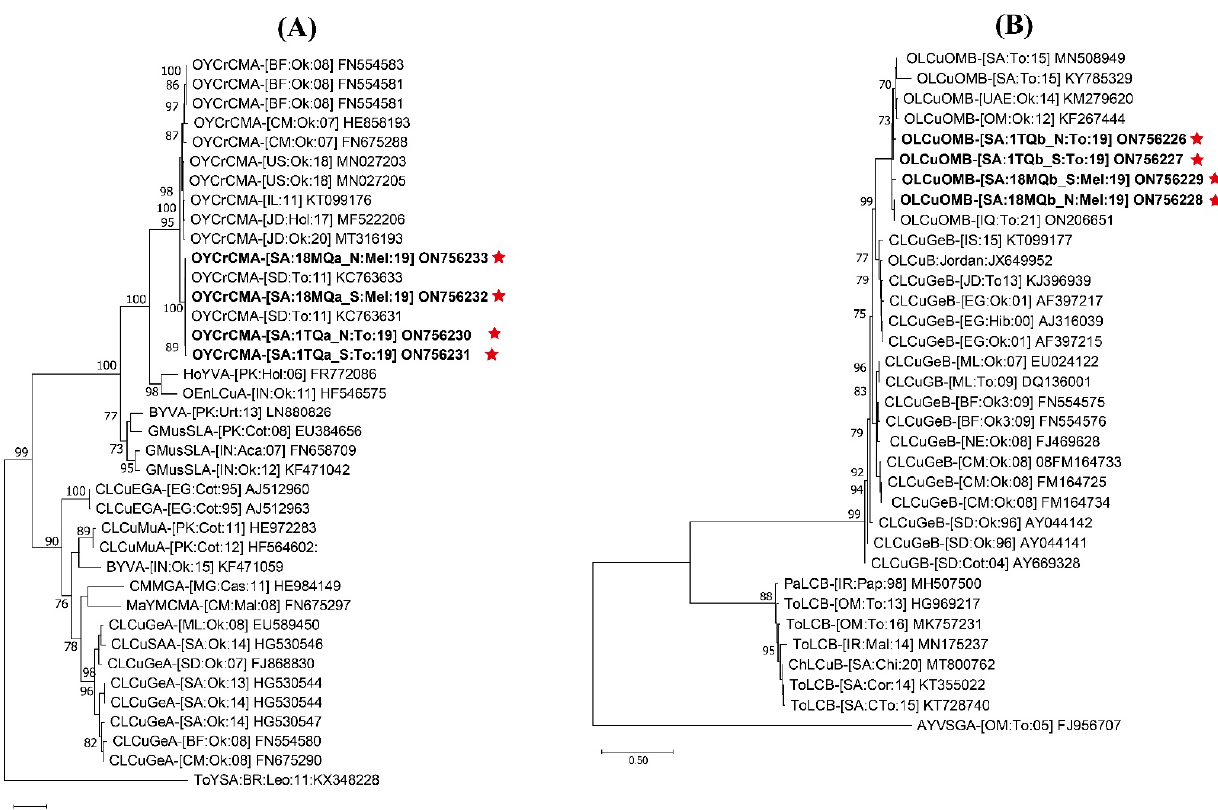
(Figure 3A). Based on the taxonomic criteria for the family Alphasatellitidae [6,29], the